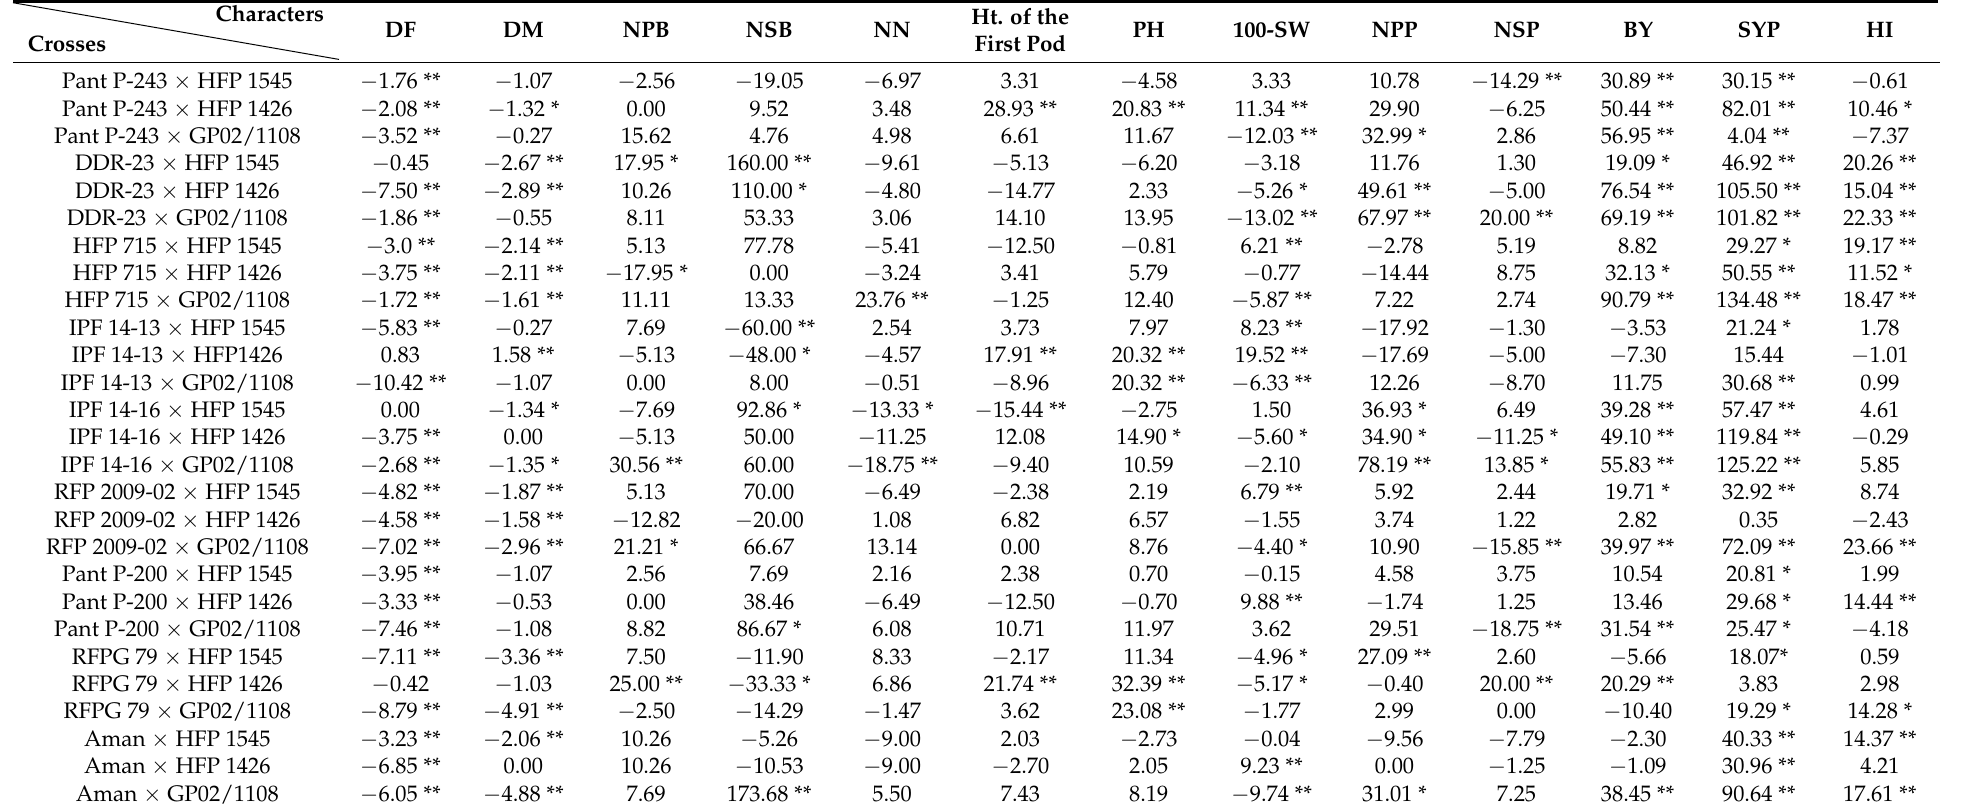
Table 7. Estimates of heterobeltiosis for different characters in field